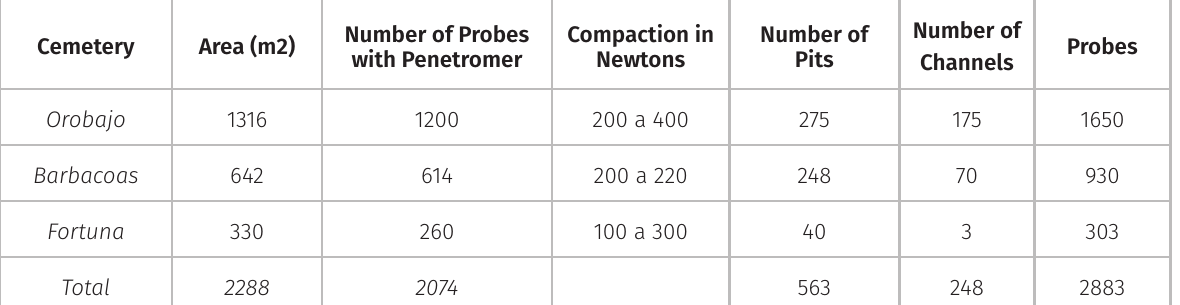
Table II. Field assessment data for each cemetery.